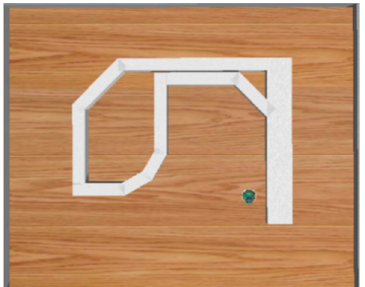
Figure 11. Training environment of the mobile robot wall-following control.